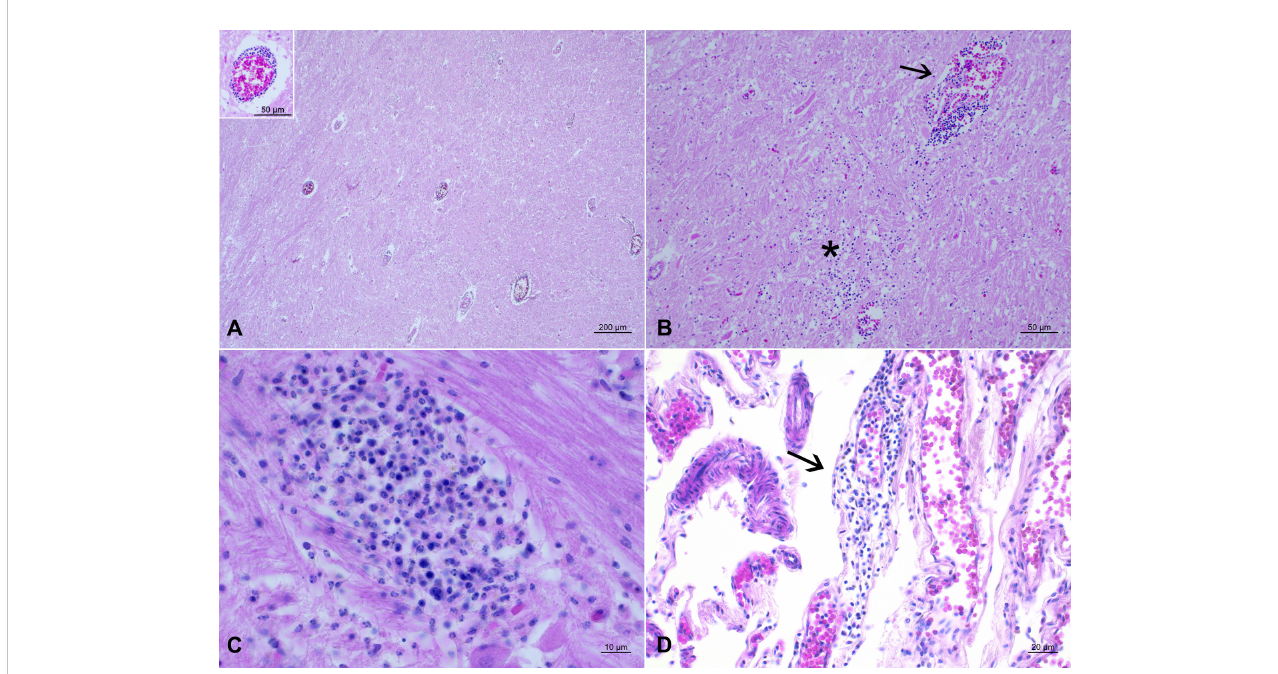
FIGURE 2 Neuropathological lesions observed in the stranded Cuvier ’ s beaked whale. HE. (A) Thalamus. Severe encephalitis with several perivascular mononuclear cuf fi ngs. Inset: perivascular cuf fi ng characterized by mononuclear cells in fi ltration. (B) Pons. Vasculitis with damage to the vessel wall causing leakage of red blood cells with formation of perivascular hemorrhages and presence of mononuclear in fl ammatory in fi ltration around it (arrow) and invading the underlying neuroparenchyma (asterisk). (C) Pons. Small granuloma, as an outcome of a microabscess, constituted of macrophages, lymphocytes, and plasma cells. (D) Parietal cortex. Focal and mild non-suppurative meningitis